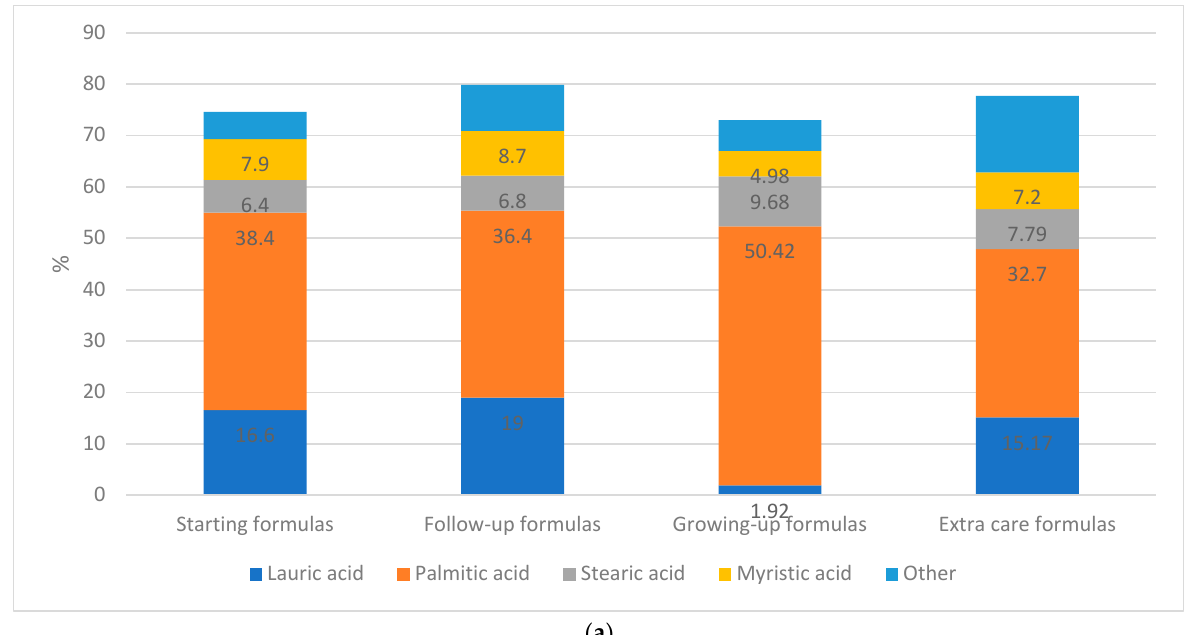
Figure 1. ( a ) Percentage of total energy, macronutrient, and added sugar distribution in 100 g of